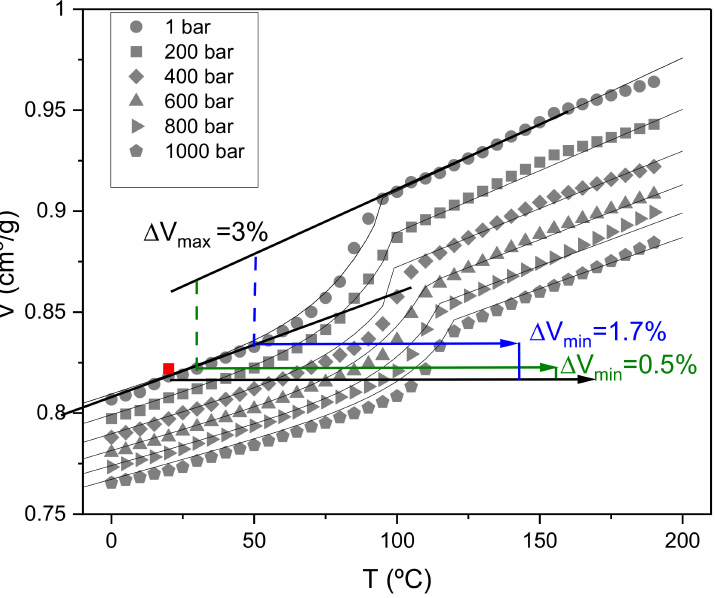
Figure 7. PVT diagram obtained under the isobaric cooling condition at 5 ◦ C/min for PHBH polymer. Grey symbols are experimental-specific volumes at the pressures specified in the legend. Lines correspond to the Tait equation. The red symbol corresponds to the density of the printed part measured using an electronic densitometer (not PVT data). Changes in the specific volume are discussed in the text (lines in blue correspond to changes when T bed = 50 ◦ C, and lines in green correspond to changes for T bed = 30 ◦